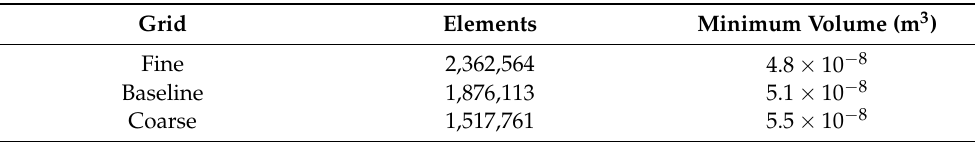
Table 3. The number of elements in the three grid